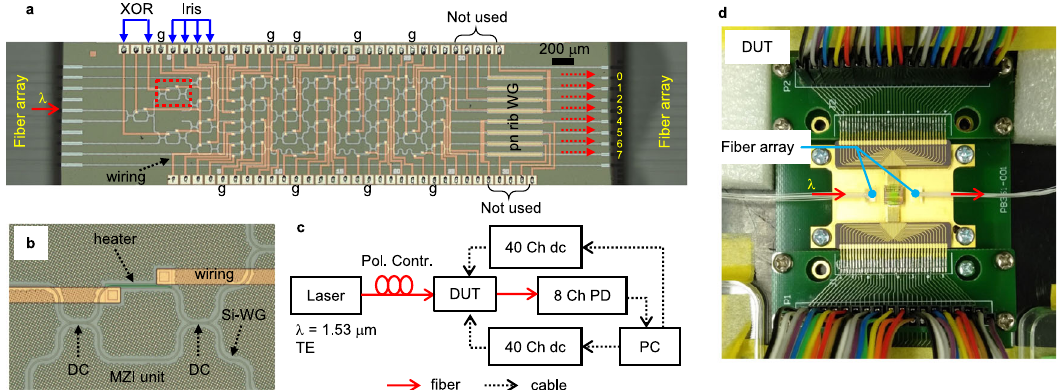
Fig. 2 Fabricated PPC chip and measurement setup. a Microscope picture of the fabricated chip with fi ber arrays coupled. b An enlarged MZI unit in the red square in ( a ). c Setup of measurement system. d Wire-bonding packaged module. XOR: exclusive OR. The letter g marks out the ground pads. WG: waveguide. The pn rib WG denotes the rib waveguides embedded with pn junctions and their corresponding pads are not used in this study. DC: directional coupler. λ denotes the laser wavelength. TE: transverse-electric polarization. Pol. Contr.: polarization controller. DUT: device under test. Ch: channel. dc: direct-current source. PD: photodetector. PC: computer. Red arrows indicate the light input and output. Blue arrows indicate the data input from electrical domain.